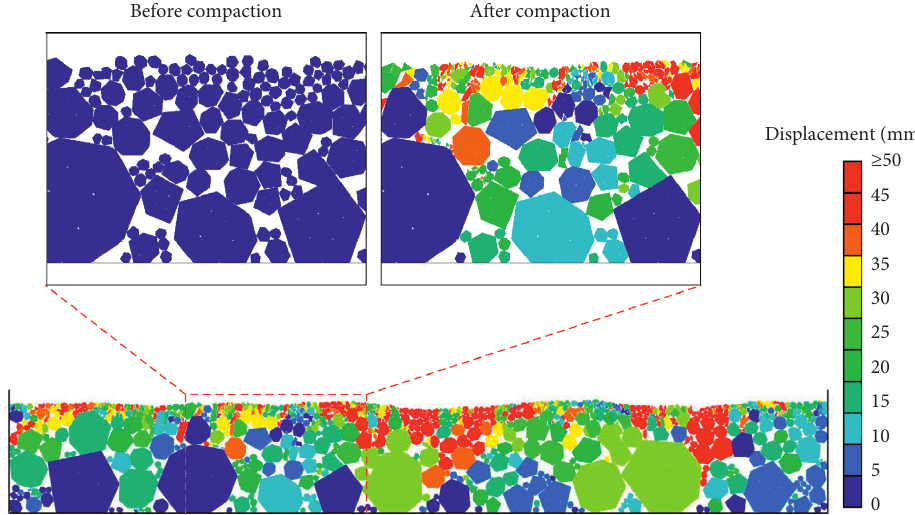
Figure 13: Displacement of rockfill particles after vibratory compaction for eight passes.